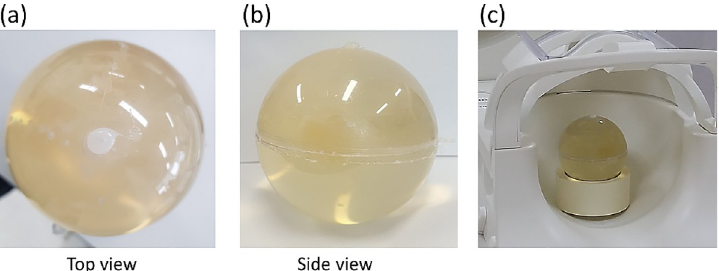
Fig 3. Pictures of the phantom. (a,b) Pictures of the completed spherical phantom. The white blob at the top of the phantom is settled hot glue. (c) Phantom positioned for imaging in a head-neck array